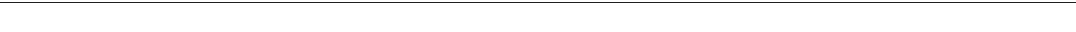
Fig. 3 NK cell speci fi cation, maturation, and effector functions require mTORC1 activity. a Cumulative ratio and enumeration of NK cells (CD3 − CD19 − NK1.1 + ) present in BM, spleen, and peripheral lymph nodes (pLNs) from control ( Rptor fl / + / Ncr1 -Cre + ) versus Raptor Δ NK ( Rptor fl / fl / Ncr1 -Cre + ) mice. b Flow cytometric analysis and cumulative frequencies of NK cell (CD3 − CD19 − NK1.1 + NKp46 + ) subsets found in the BM, spleen, and pLNs from control versus Raptor Δ NK mice. c Statistical quanti fi cation of IFN- γ + splenic NK cells (CD3 − CD19 − NK1.1 + NKp46 + ) and the MFI of IFN- γ among IFN- γ + NK cells following stimulation with PMA and ionomycin in the presence of GolgiPlug for 6 h. d Flow cytometric analysis and cumulative frequencies of CD107a + cells among Yac-1 targets in the presence of GolgiStop for 6 h. e The cumulative ratio of RMA-S cell rejection 18 h after intraperitoneal injection of a 1:1 mixture of RMA and RMA-S cells into each mouse. f , g Flow cytometric analysis and cumulative data depicting the expression of perforin and granzyme B ( f ), CD98 and CD71, and uptake of 2-NBDG ( g ) within total splenic NK cells (CD3 − CD19 − NK1.1 + NKp46 + ) and the indicated subpopulations thereof. The MFI was calculated relative to total NK cells or to the CD27SP subset of NK cells from control littermates. CD27SP, DP, and CD11bSP represent CD27 + CD11b − , CD27 + CD11b + , and CD27 ― CD11b + NK cell subsets, respectively. Each dot represents one mouse, and the experiments were replicated 3 ( c ), 4 ( g ), 5 ( a , b ), 7 ( d ), or 9 ( f ) times; error bars represent SD; ∗ p < 0.05, ∗∗ p < 0.01, ∗∗∗ p < 0.001, and ∗∗∗∗ p < 0.0001; unpaired two-tailed Student ’ s t test with Welsh ’ s correction ( a – d , f , g ); generalized linear models ( e ). Each of the shapes represents a matched pair of littermates in an individual experiment, and the horizontal red line represents the median ( e